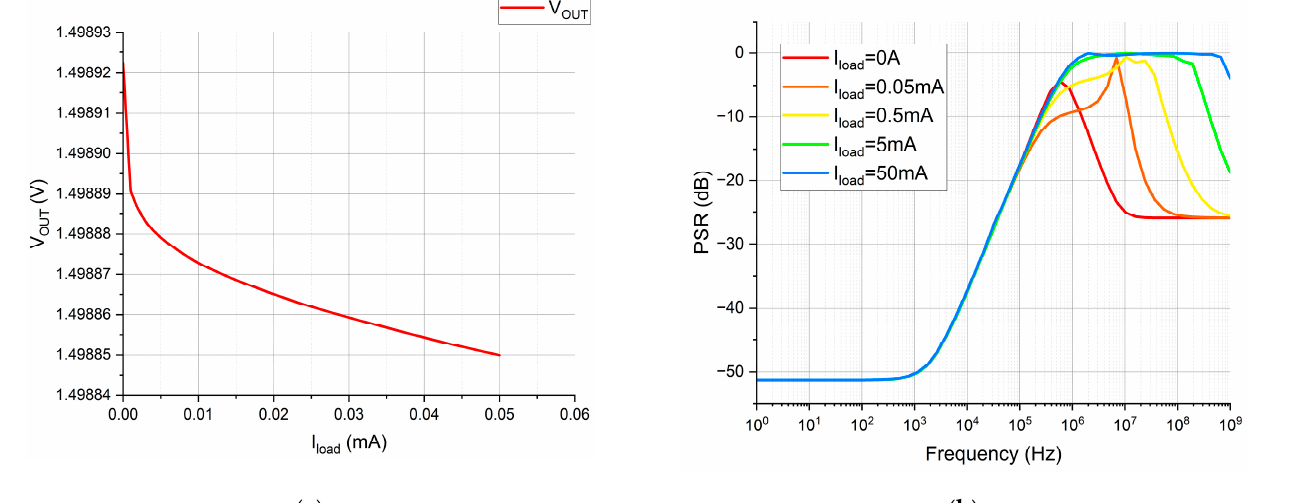
Figure 10. ( a ) Simulated load regulation . ( b ) Simulated PSR versus frequency under different load current (from 0 A to 50 mA).